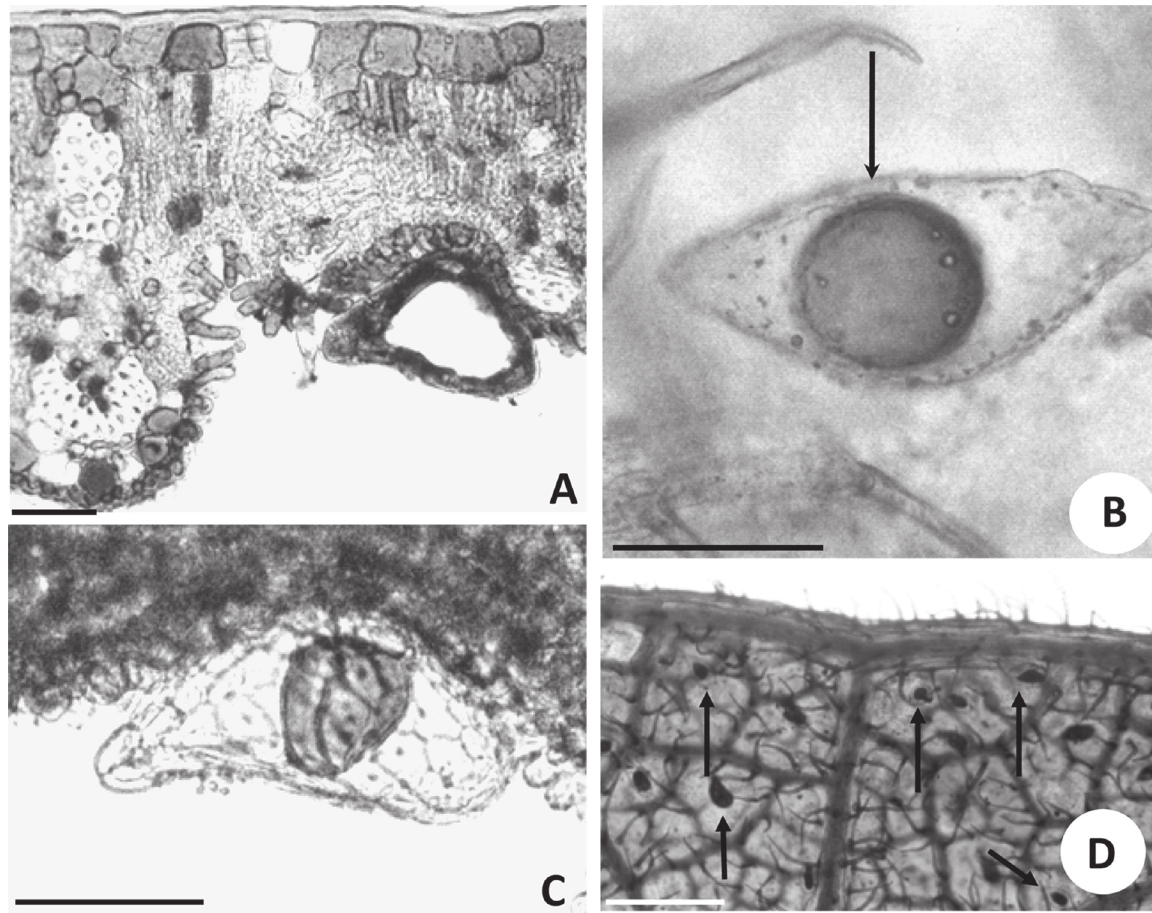
Figure 2 - Glands seen in light microscopy. ( A ) Transversal section of the leaf blade of Bauhina rufa (SPF 79418), showing a gland inserted in an intervenal region, scale bar =50 µm. ( B ) Segment of cleared leaf showing lipid content inside a gland of B. brevipes (SPF 142960) and non-glandular trichome (arrow), scale bar = 100 µm. ( C ) Transversal section of leaf blade of B. brevipes , showing a gland in lateral view inserted in a small depression on the abaxial surface with a lipid drop visible inside, scale bar = 100 µm. ( D ) Segment of a cleared leaf of B. aculeata (RB 94867) showing glands (arrows) distributed in intervenal regions, scale bar = 400